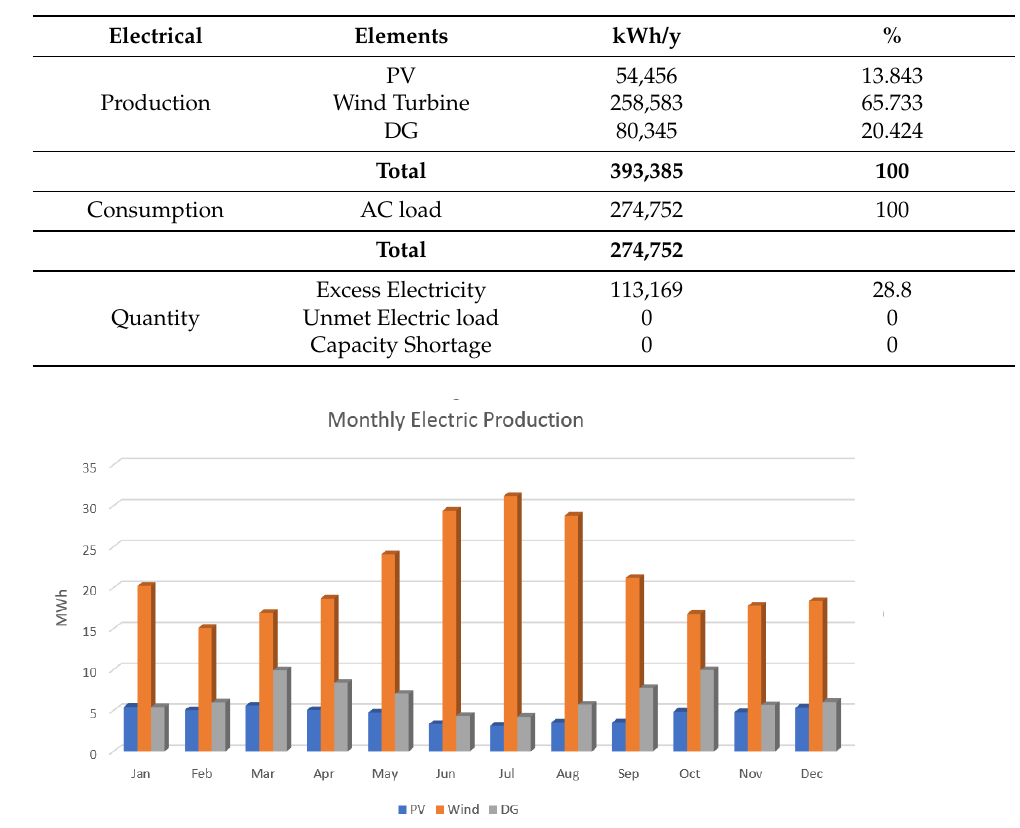
Table 8. Augmented Electrical Result for PV/Wind/Battery/DG.